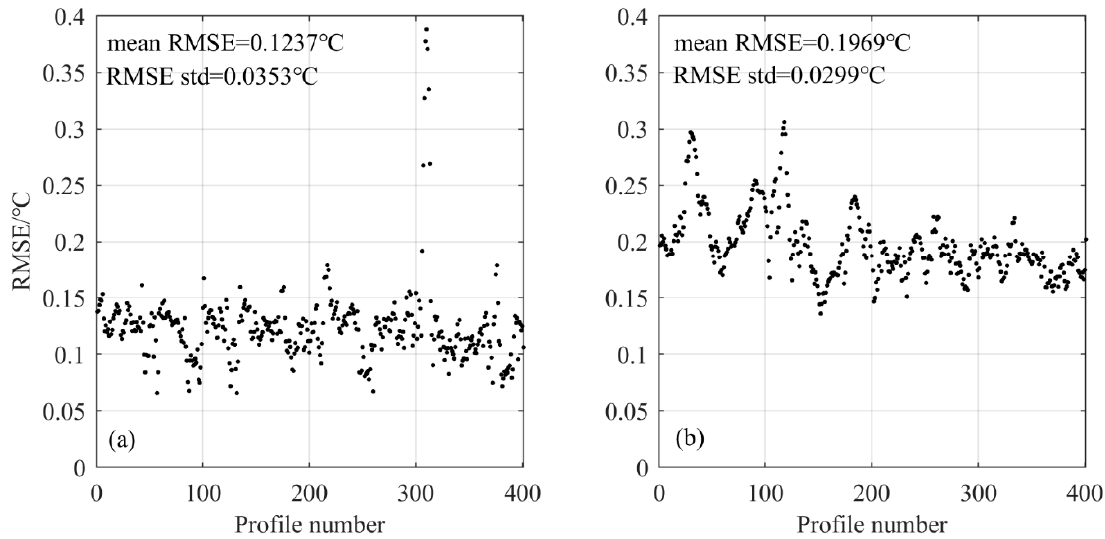
Figure 13. The RMSE of temperature inversion at O 1 and S 17. ( a ) O 1 , ( b ) S 17 .